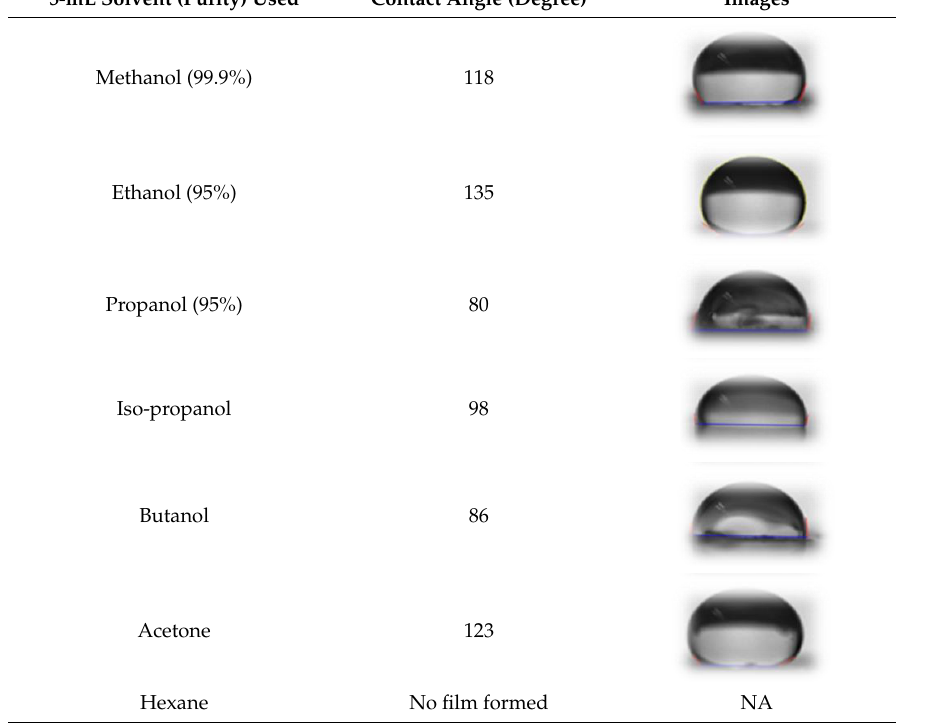
Table 1. Static water contact angle (CA) of the hydrophobic silica film fabricated with various solvents. 5-mL Solvent (Purity) Used Contact Angle (Degree) Images Methanol (99.9%)